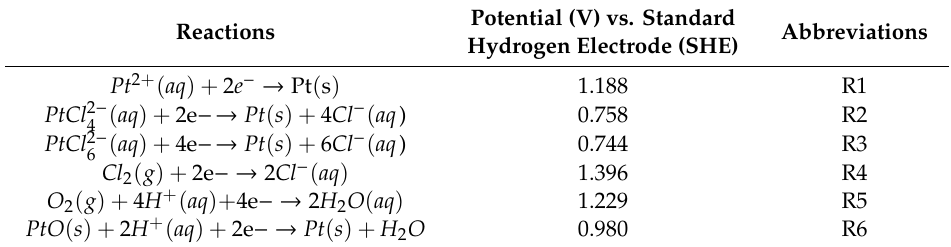
Table 1. Electrochemical potential of different reactions, data from [13].